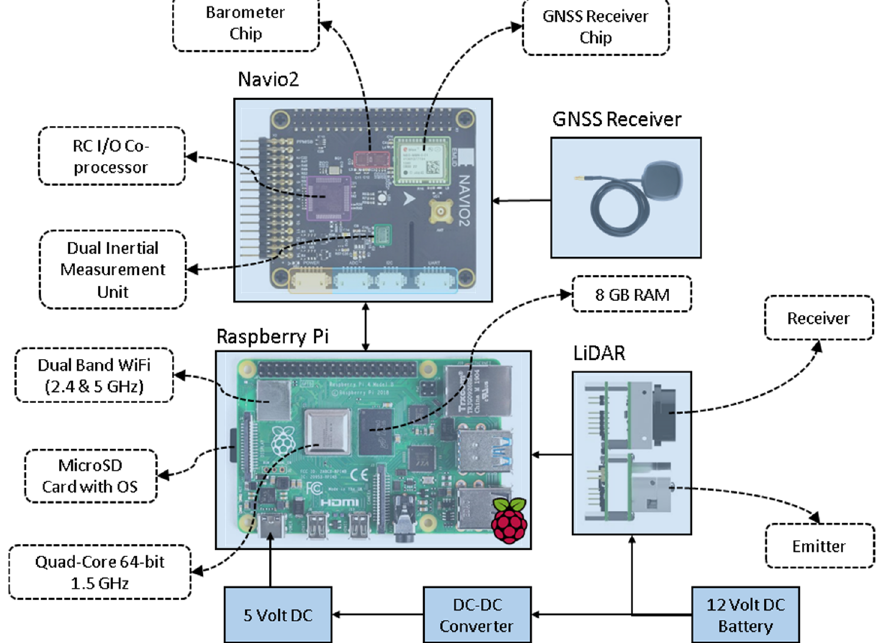
Figure 1. Schematic overview of the components that were used in the CropBioMass (CBM) sensor. The integrated systems consist of a solid-state LiDAR sensor, onboard Raspberry Pi 4 computer, and an autopilot controller that was used for the embedded GNSS logger.